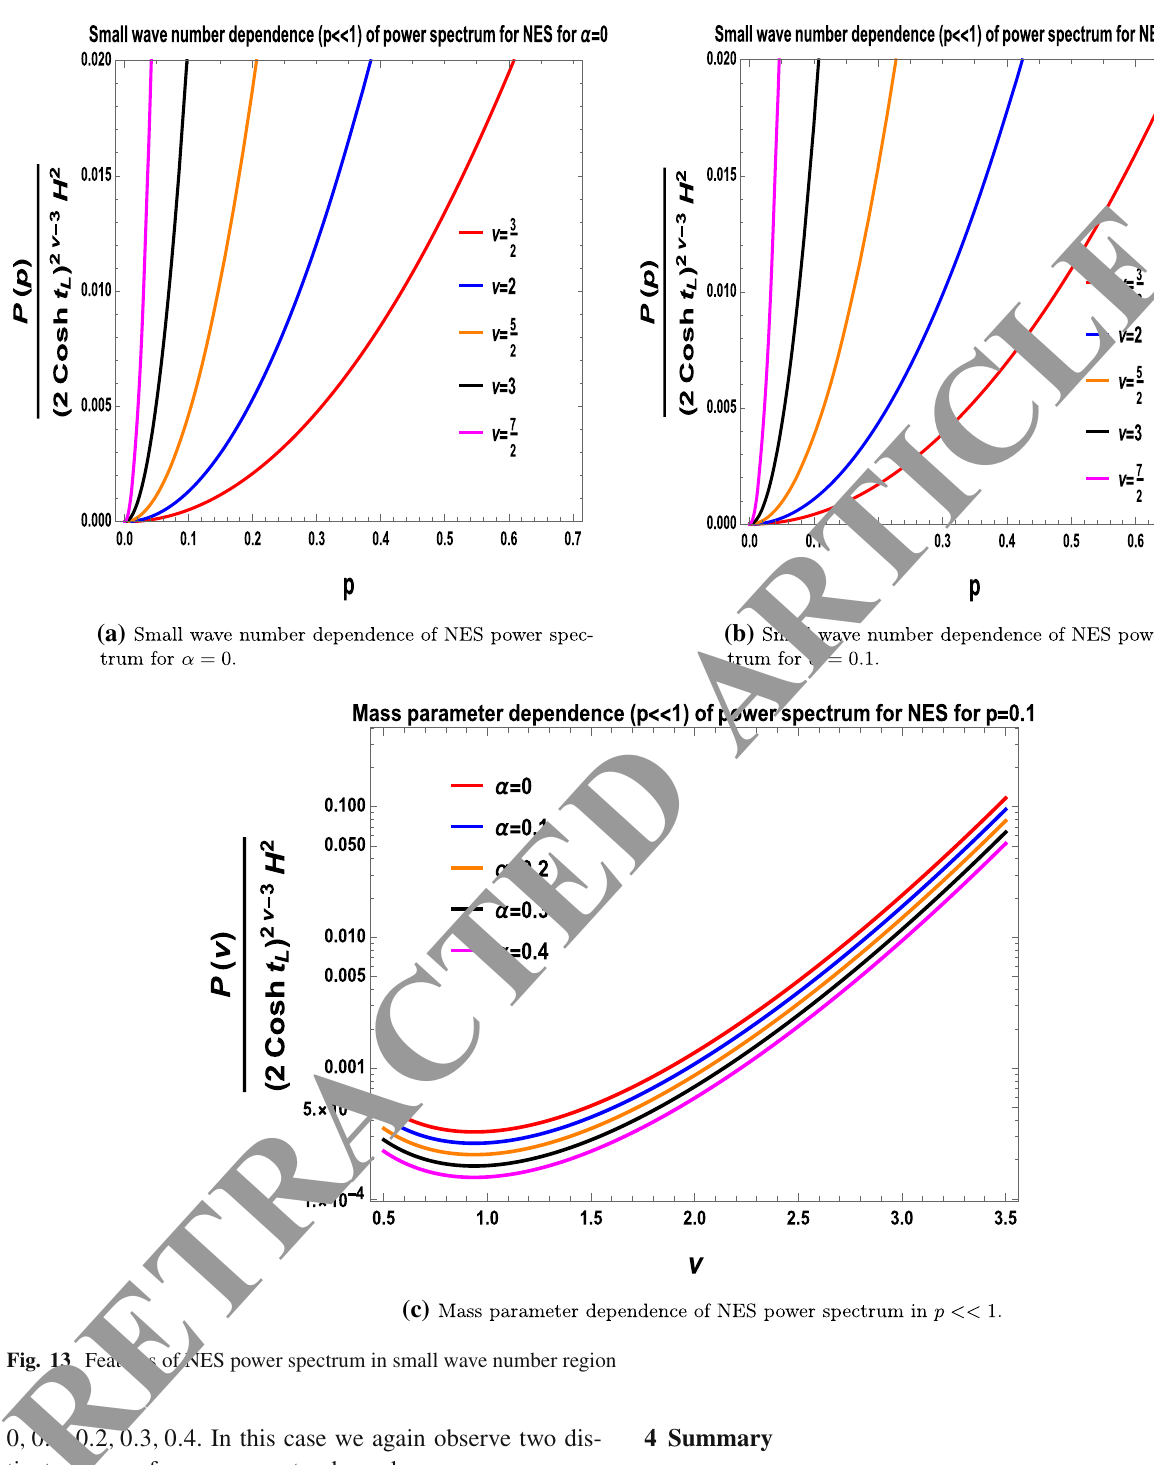
0 , 0 . 1 , 0 . 2 , 0 . 3 , 0 . 4. In this case we again observe two dis- tinct regions of mass parameter